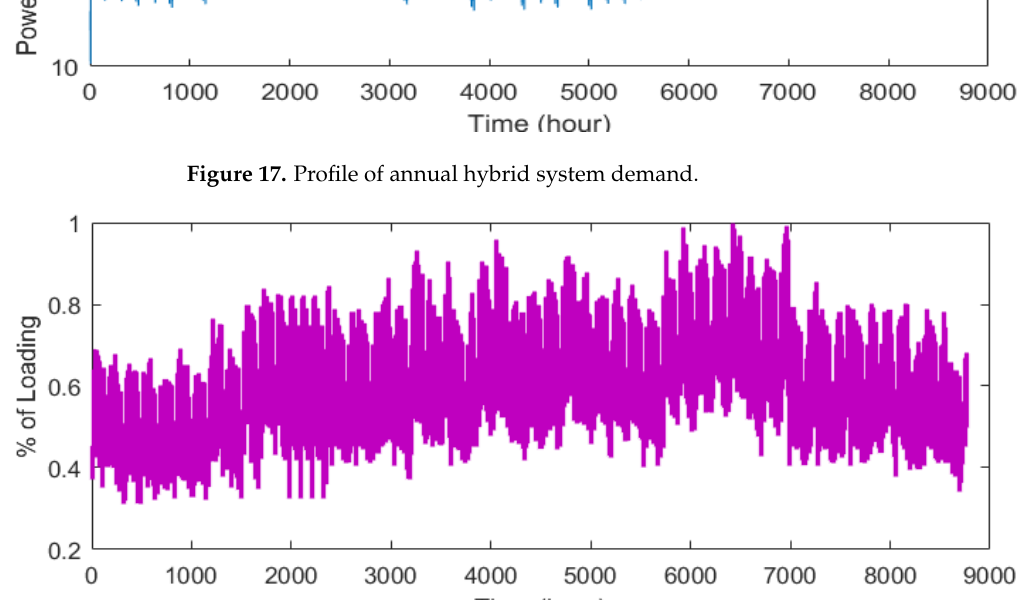
Figure 18. Percentage of annual network peak load.